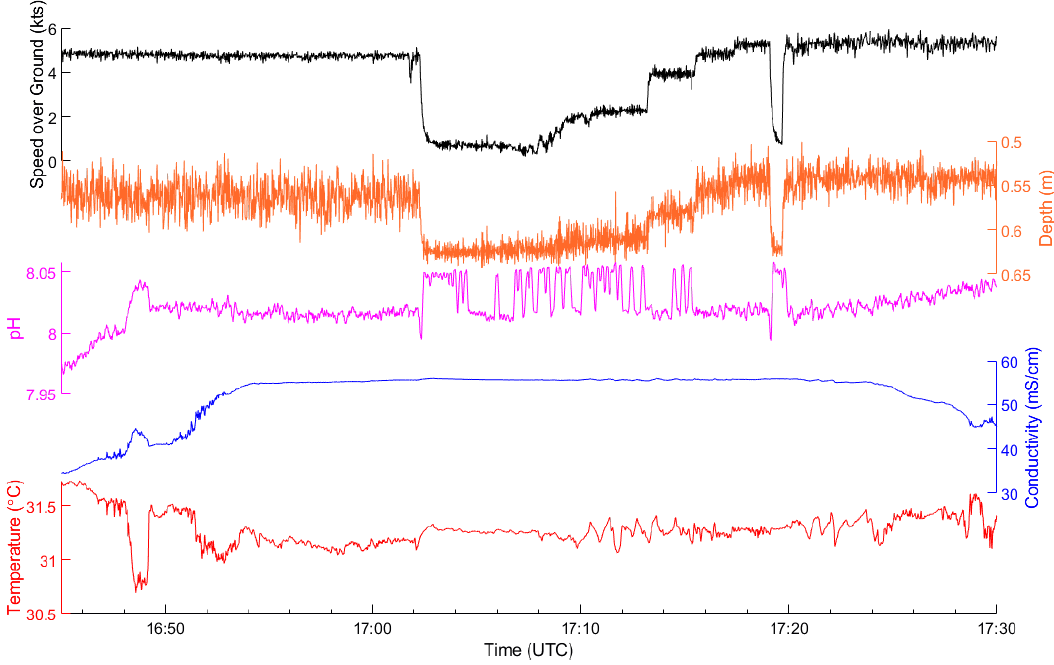
Figure 7. Effect of speed (black) of CW4 on depth (orange), pH (pink), conductivity (blue), and temperature (red). Times are in UTC (+6 h from Belize). Data were collected on Transect 4 on 20 October 2019, are factory calibrated, and smoothed with a moving median of 11 data points.